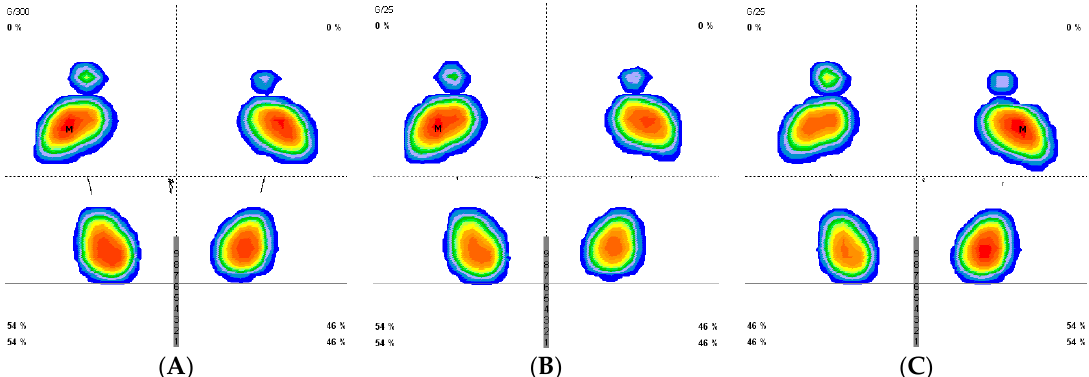
Figure 1. Stabilometry pattern before and after stretching (Previous stabilometry ( A ) post continuous stretch ( B ) and post intermittent stretch( C )).